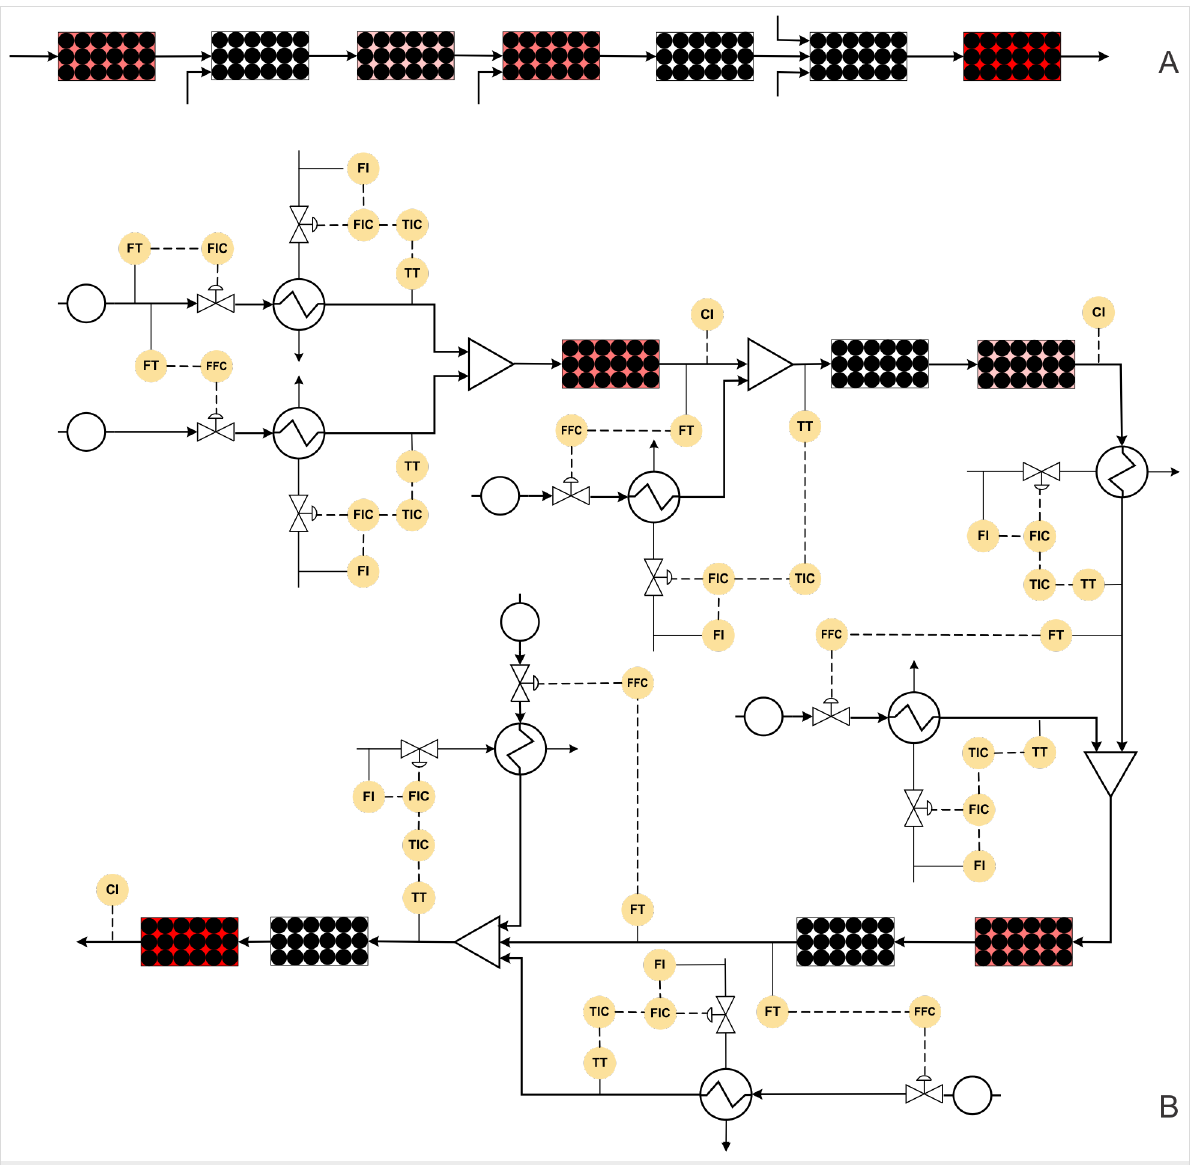
Figure 9: (A) Block diagram representation of the process shown in Scheme 7 (colours for each reactor shows different reactor temperatures), (B) piping and instrumentation diagram of Scheme